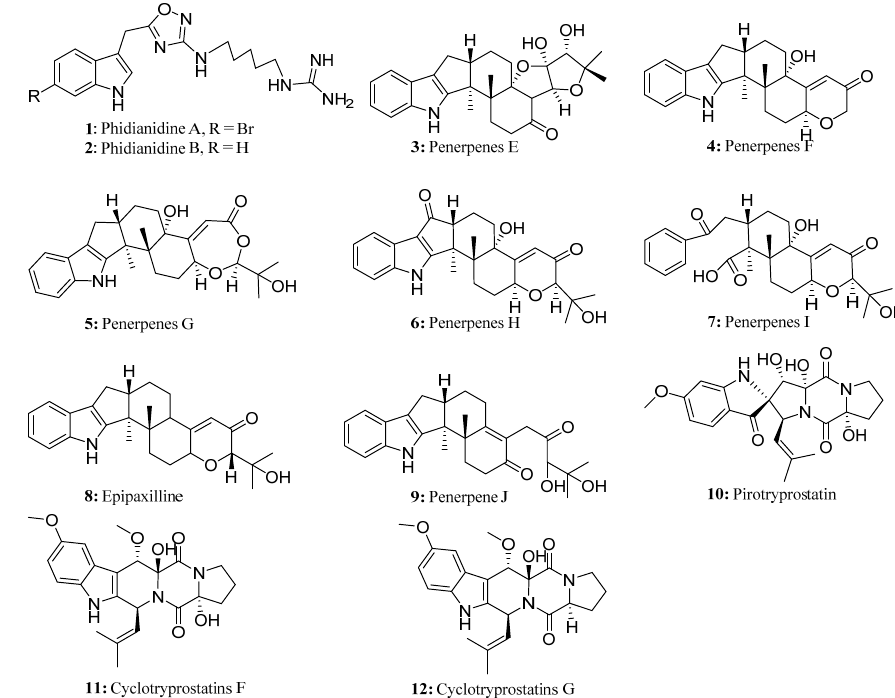
Figure 1. The structure of compounds 1–12 . Discodermindole ( 13a ) and 6-hydroxydiscodermindole ( 13b ), isolated from the Ba- hama sponge Discodermia polydiscus, and trachycladindoles A-G ( 14a - g ), isolated from the South Australian sponge Trachycladus laevispirulifer , belong to the rather limited class of indole alkaloids containing a 2-aminoimidazoline substituent at position 3. In addition, they all, with the exception of compound 14g , have one or more bromine atoms in their structure, which is common for many secondary metabolites of marine origin [11–13] (Fig- ure 2).